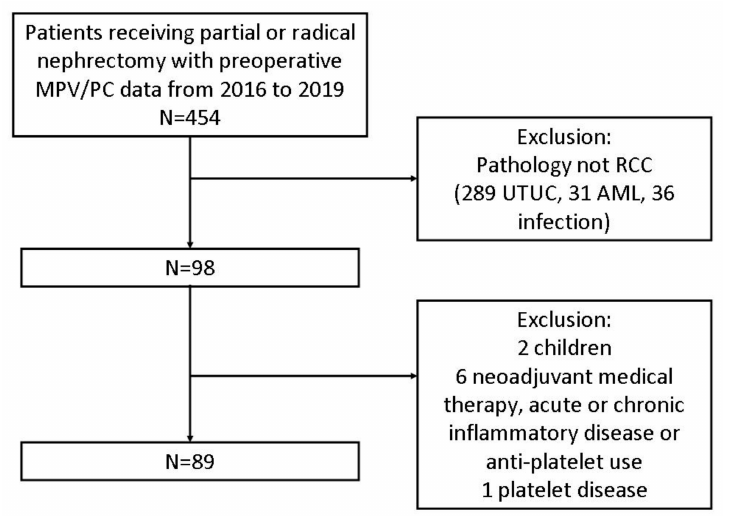
Figure 1. Enrollment of participants of this study. MPV/PC: mean platelet volume/platelet count; RCC: renal cell carcinoma; UTUC: upper tract urothelial carcinoma; AML: